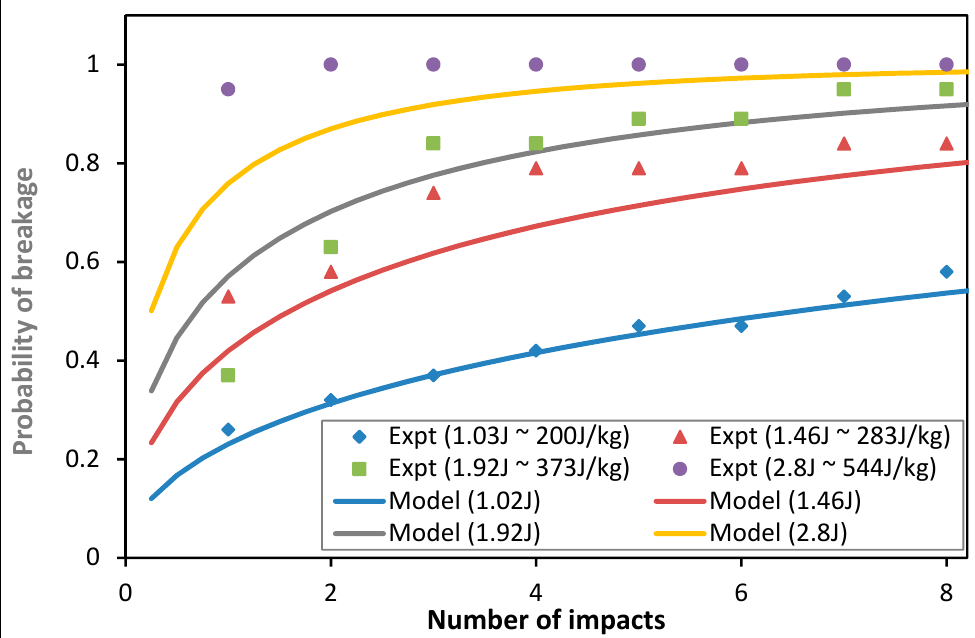
Figure 9. Experimental and Model Breakage probability curves for a − 26.5 + 22.4 mm Coal sample.